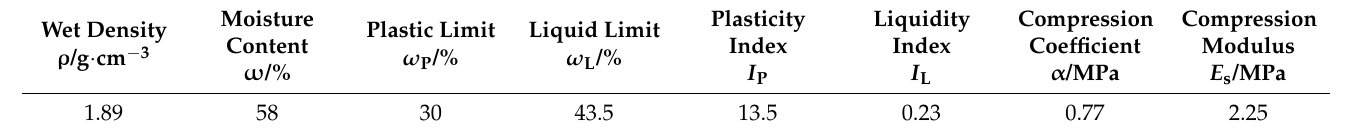
Table 1. Physical and mechanical properties of coastal soft clay.